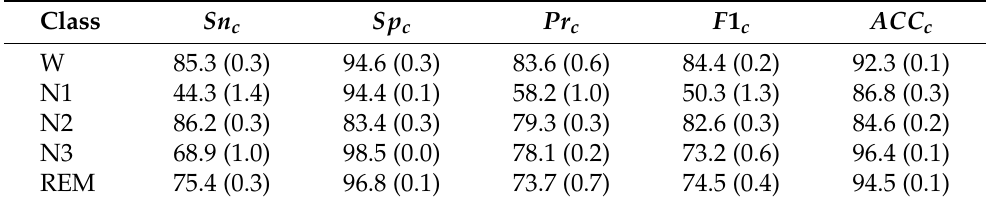
Table 5. Detailed per-class best test performance obtained with CWT-TF representation from C4-M1 using CNN-RNN transfer learning network. Results are reported as the mean (std) for three